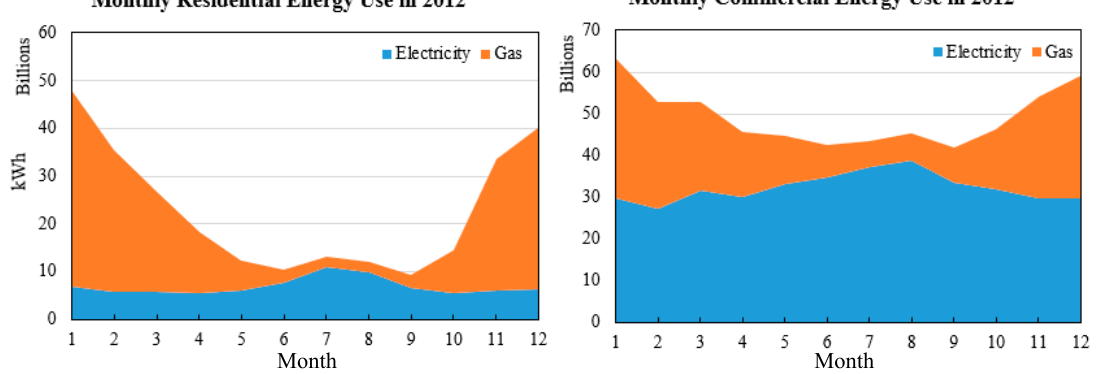
Figure 9. Monthly electricity and gas consumption in Manhattan in 2012.